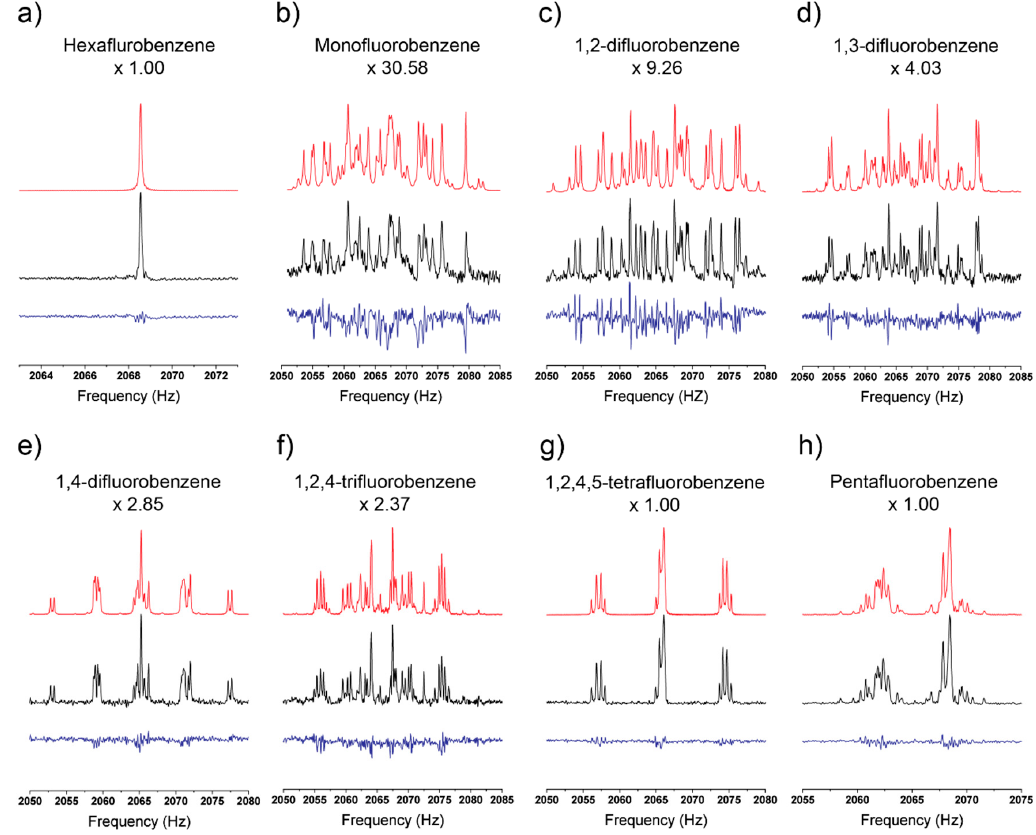
Figure 4. The 19 F region of the JCS for hexafluorobenzene ( a ), monofluorobenzene ( b ), 1,2-difluorobenzene, 1,3-difluorobenzene ( c ), 1,4-difluorobenzene ( d ), 1,2,4-trifluorobenzene ( e ), 1,2,4,5-tetrafluorobenzene ( g ), and pentafluorobenzene ( h ). The black lines are the experimentally measured spectra, the red lines are the simulated spectra, and the blue lines are the residuals between the experimental and simulated spectra. Each spectrum also has a scaling factor, denoted below the compound name, that indicates the amount the experimental, simulated, and residual data was multiplied such that the maximum peak intensities of spectra (a-h) were equivalent.